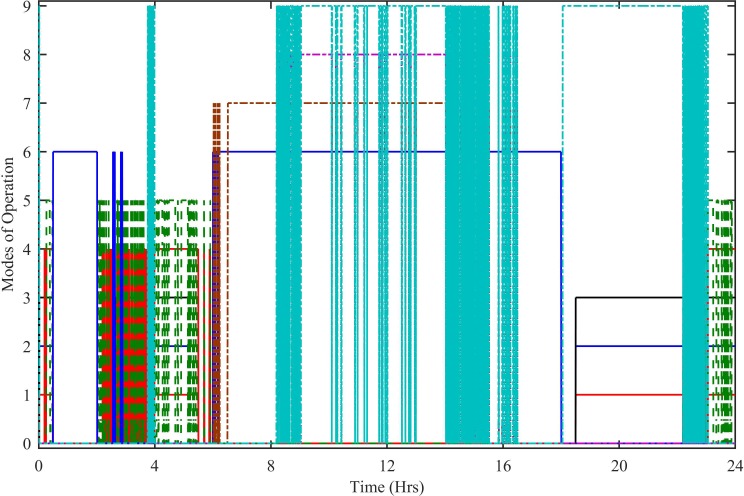
Modes of operation.